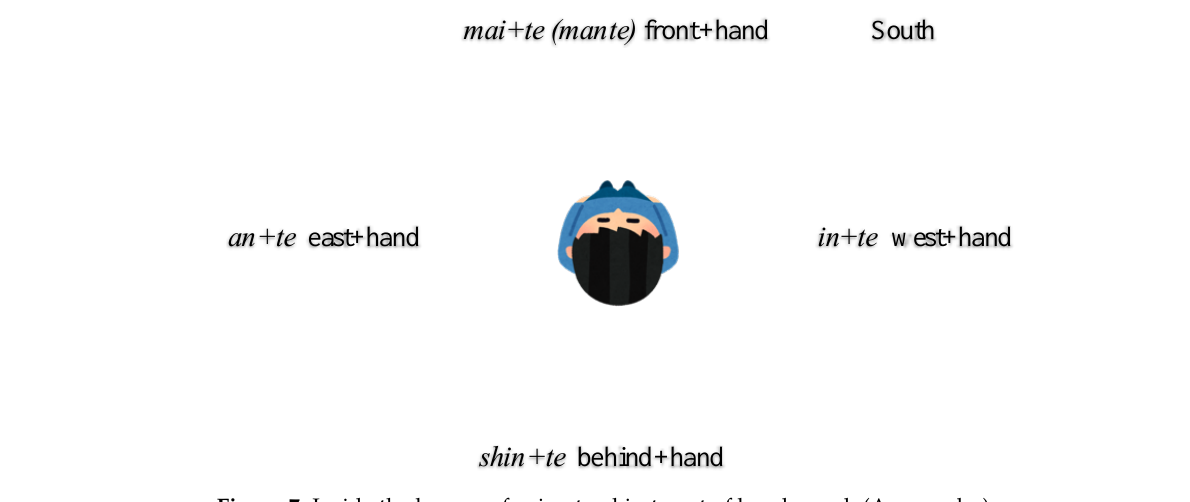
Figure 6. Inside the home, referring to objects out of hands reach (Sikāza).